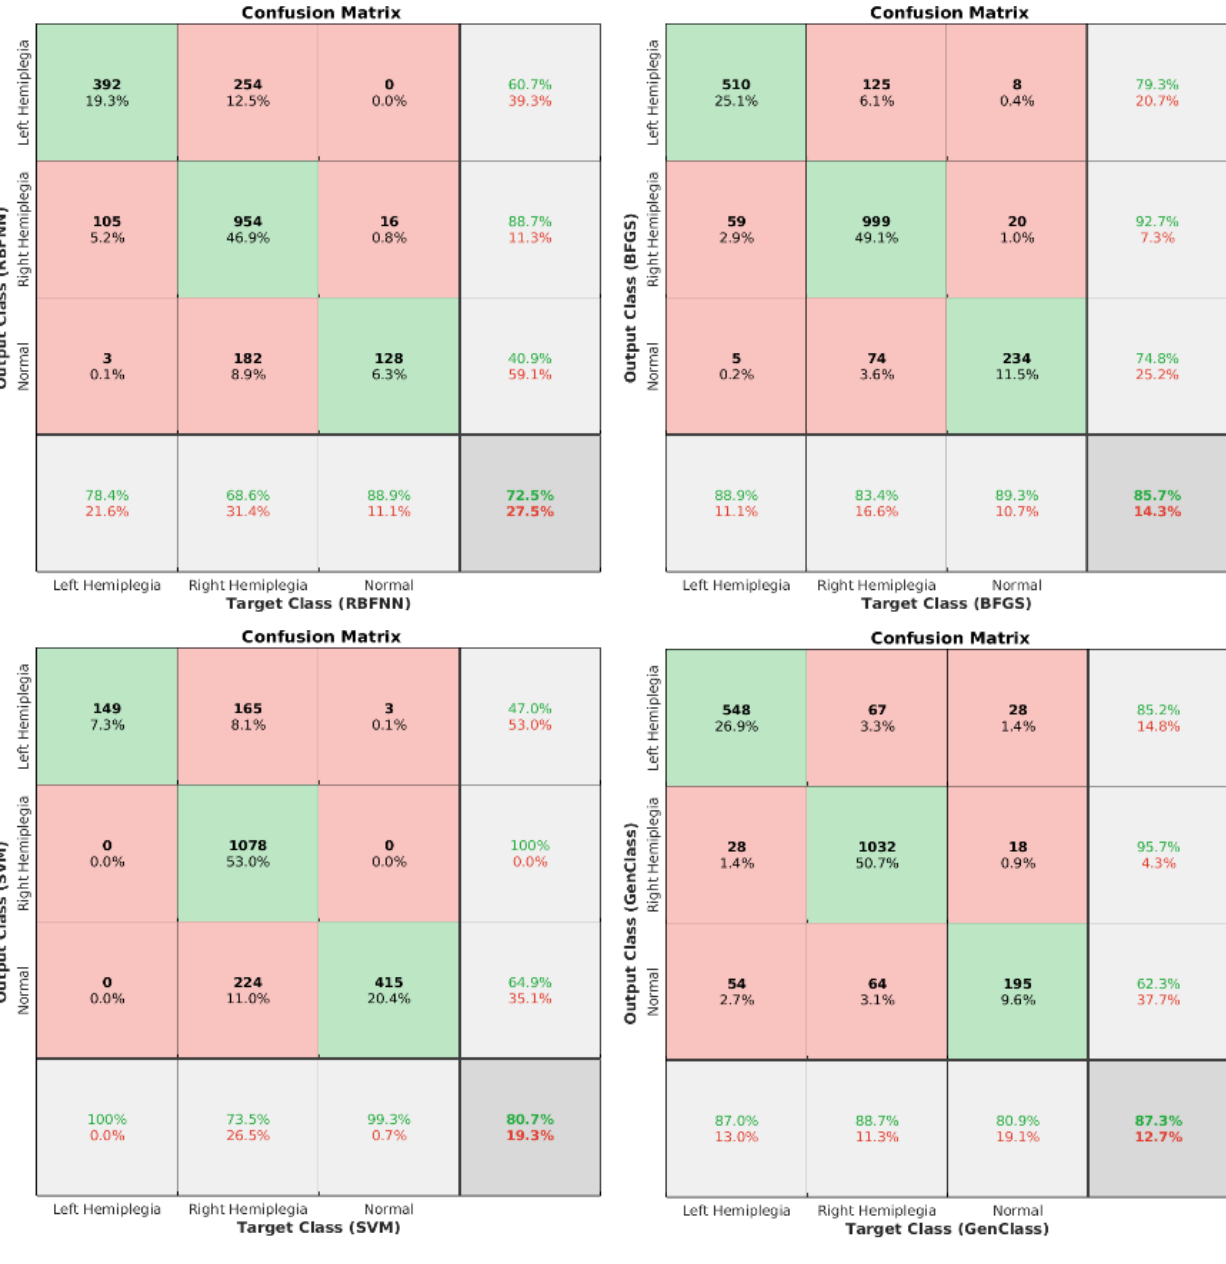
Figure 6. The compared methods confusion matrices. The current figure depicts the confusion matrices for all compared methods (RBFNN, BFGS, SVM,